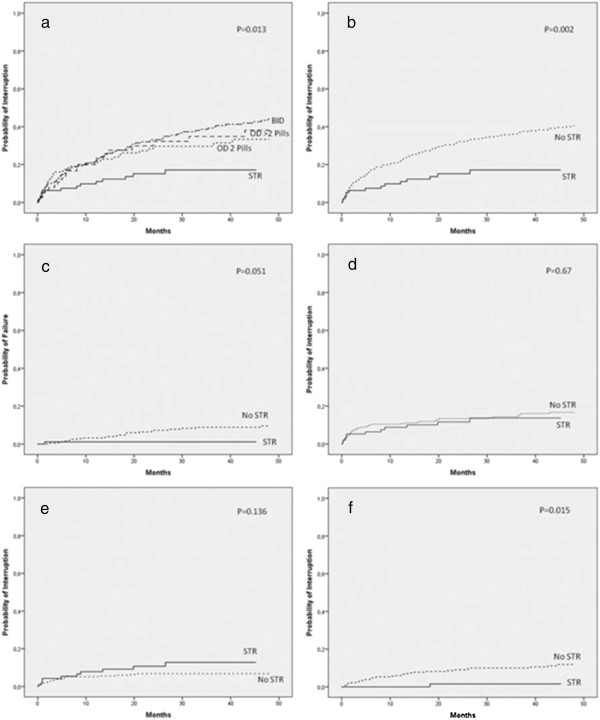
a-f: Kaplan-Meier plots estimating probability of treatment interruption for specific reasons stratified by STR vs. no-STR. Notes: (1a) overall probability of interruption by type of regimen; (1b) overall probability of interruption STR vs. no STR; (1c) probability of interruption by virological failure STR vs. no STR; (1d) probability of interruption by any side effect STR vs. no STR; (1e) probability of interruption by central nervous system side effects STR vs. no STR; (1f) probability of interruption by personal decision STR vs. no STR.